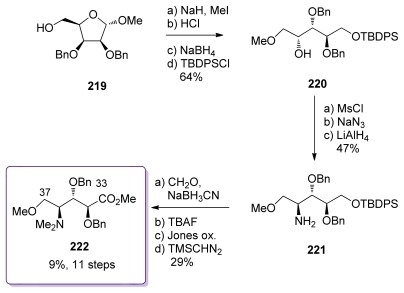
Preparation of 222.